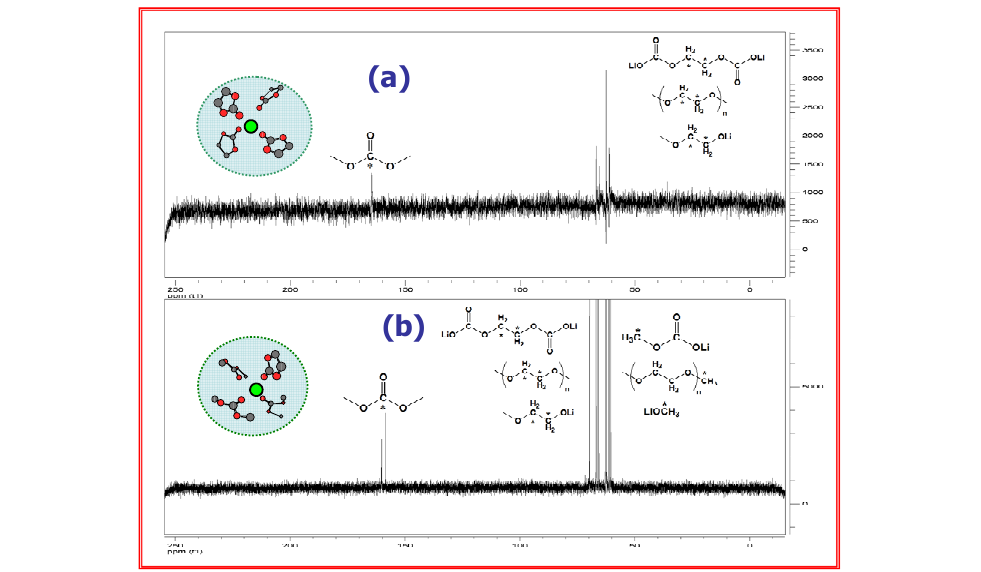
Figure 9. 13 C-NMR of graphite surfaces indicates “non-colinearity” between interphasial and bulk compositions of electrolyte. Above: SEI ingredients collected from graphitic anode in EC/DMC 5:5 (a) and 1:9 (b); Below: in EC/EMC 3:7 (a), 2:8 (b) and 1:9